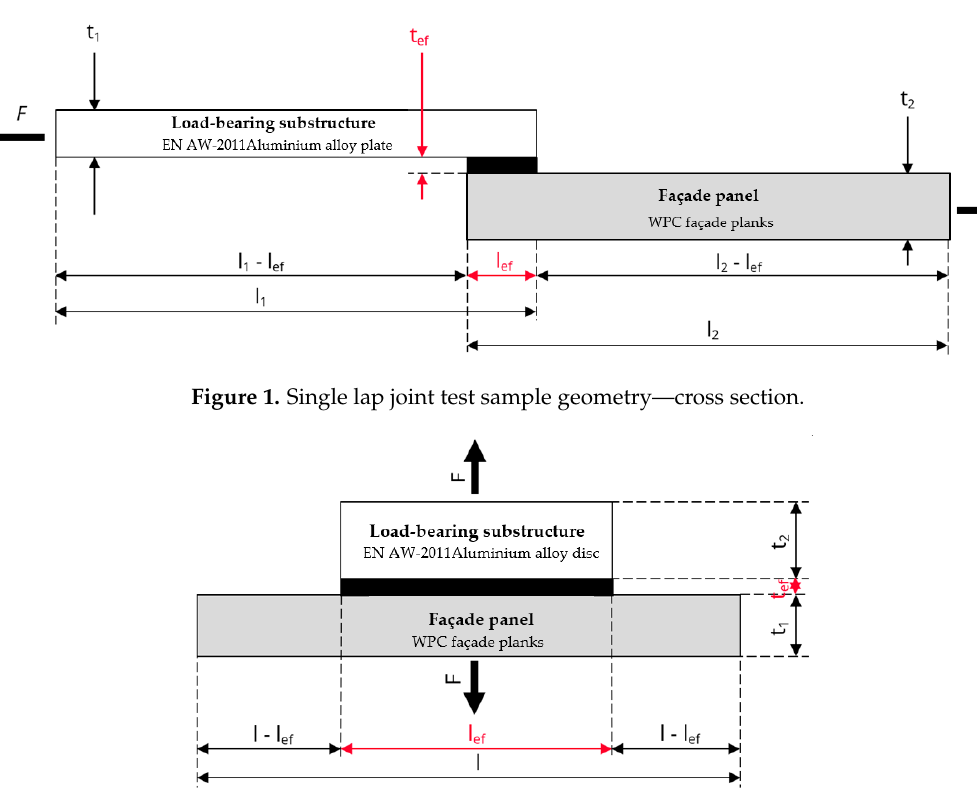
Figure 2. Adhesion test sample assembly — cross section.